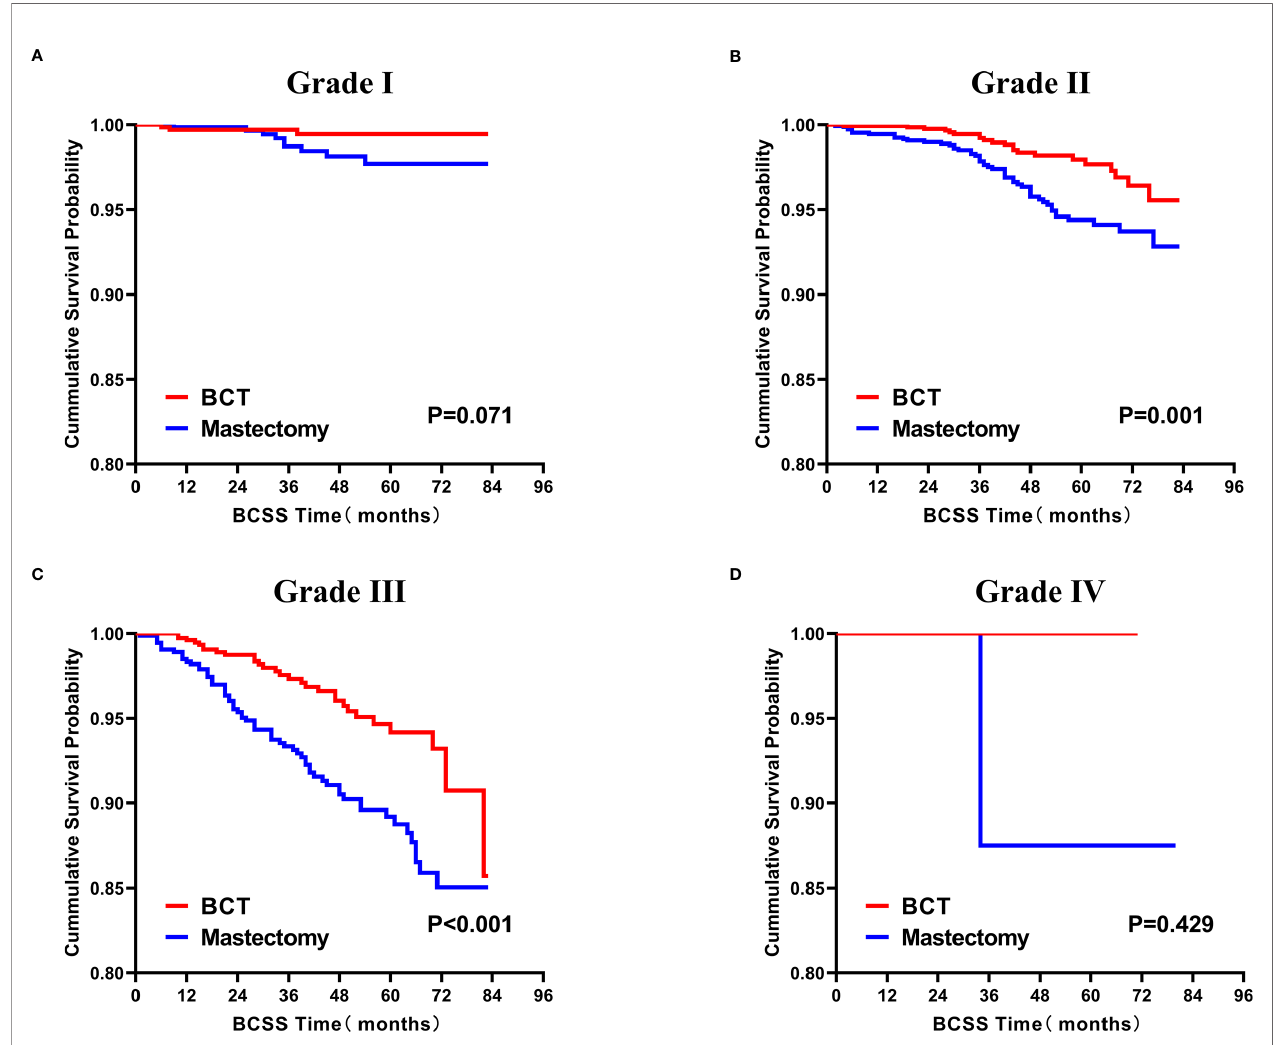
FIGURE 6 | Kaplan – Meier curves for BCSS by treatment type for all patients, strati fi ed by histological grade: (A) Grade I. (B) Grade II. (C) Grade III. (D) Grade IV. BCSS, breast cancer speci fi c survival; BCT, breast-conserving